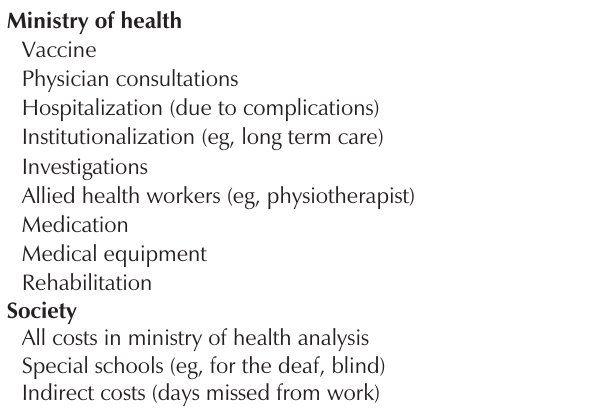
Sources of direct and indirect costs for treatment of measles, mumps and rubella from the perspective of a ministry of health and society